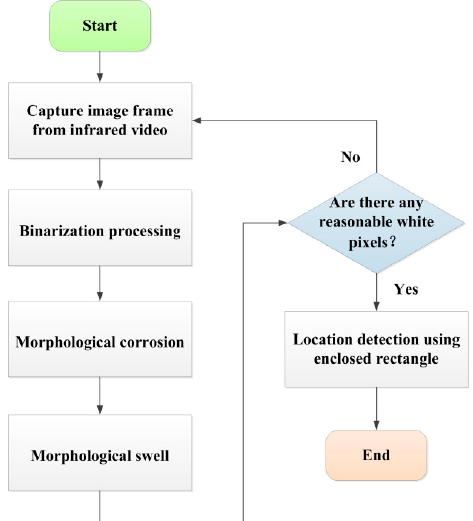
Figure 2. Flowchart of the cutting-unit location obtained based on the morphology.